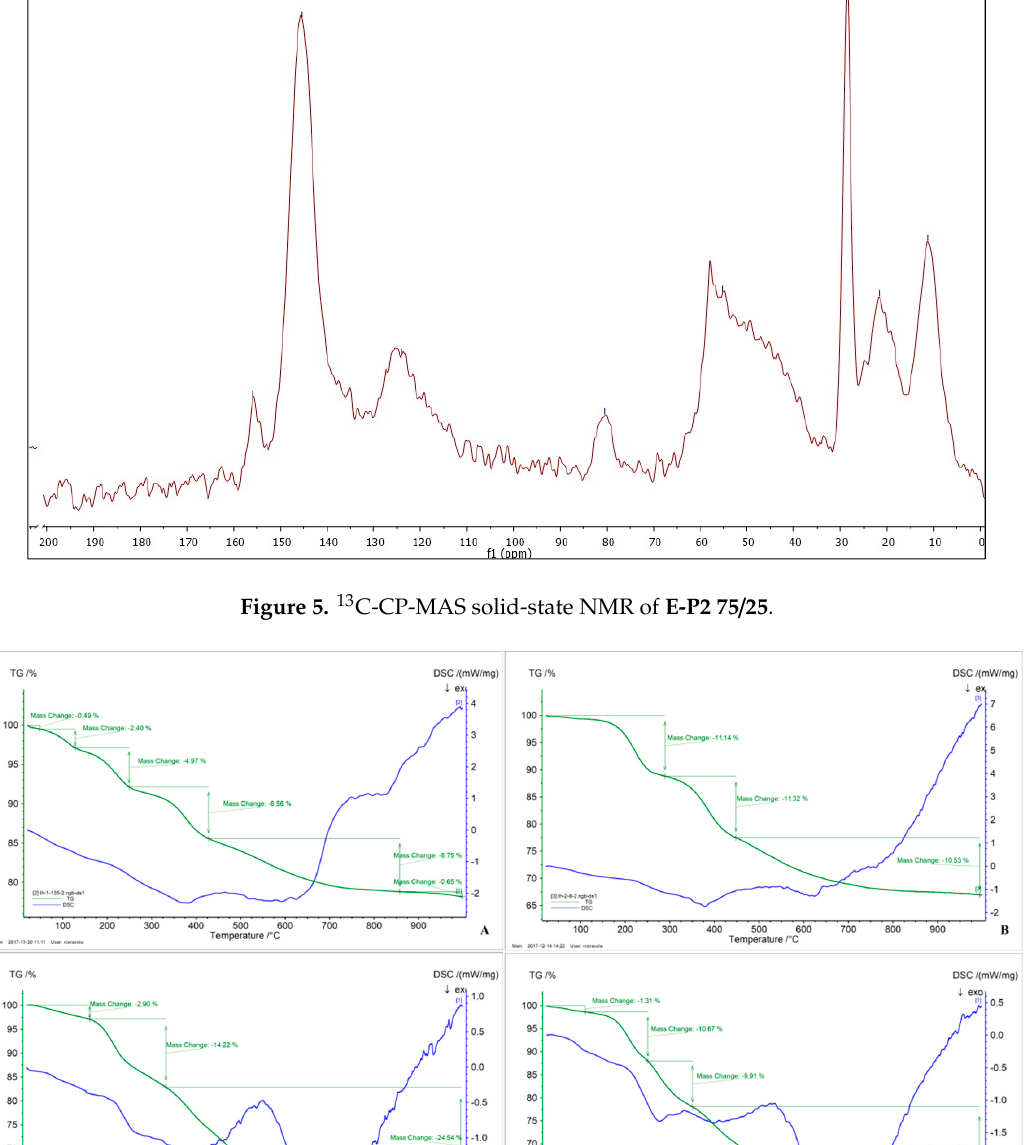
Figure 6. TGA ‐ DSC of ( A ) E ‐ P1 90/10 . ( B ) E ‐ P1 75/25 . ( C ) E ‐ P2 75/25 , ( D ) E ‐ P3 75/25 . Figure 6. TGA-DSC of ( A ) E-P1 90 / 10 . ( B ) E-P1 75 / 25 . ( C ) E-P2 75 / 25 , ( D ) E-P3 75 / 25